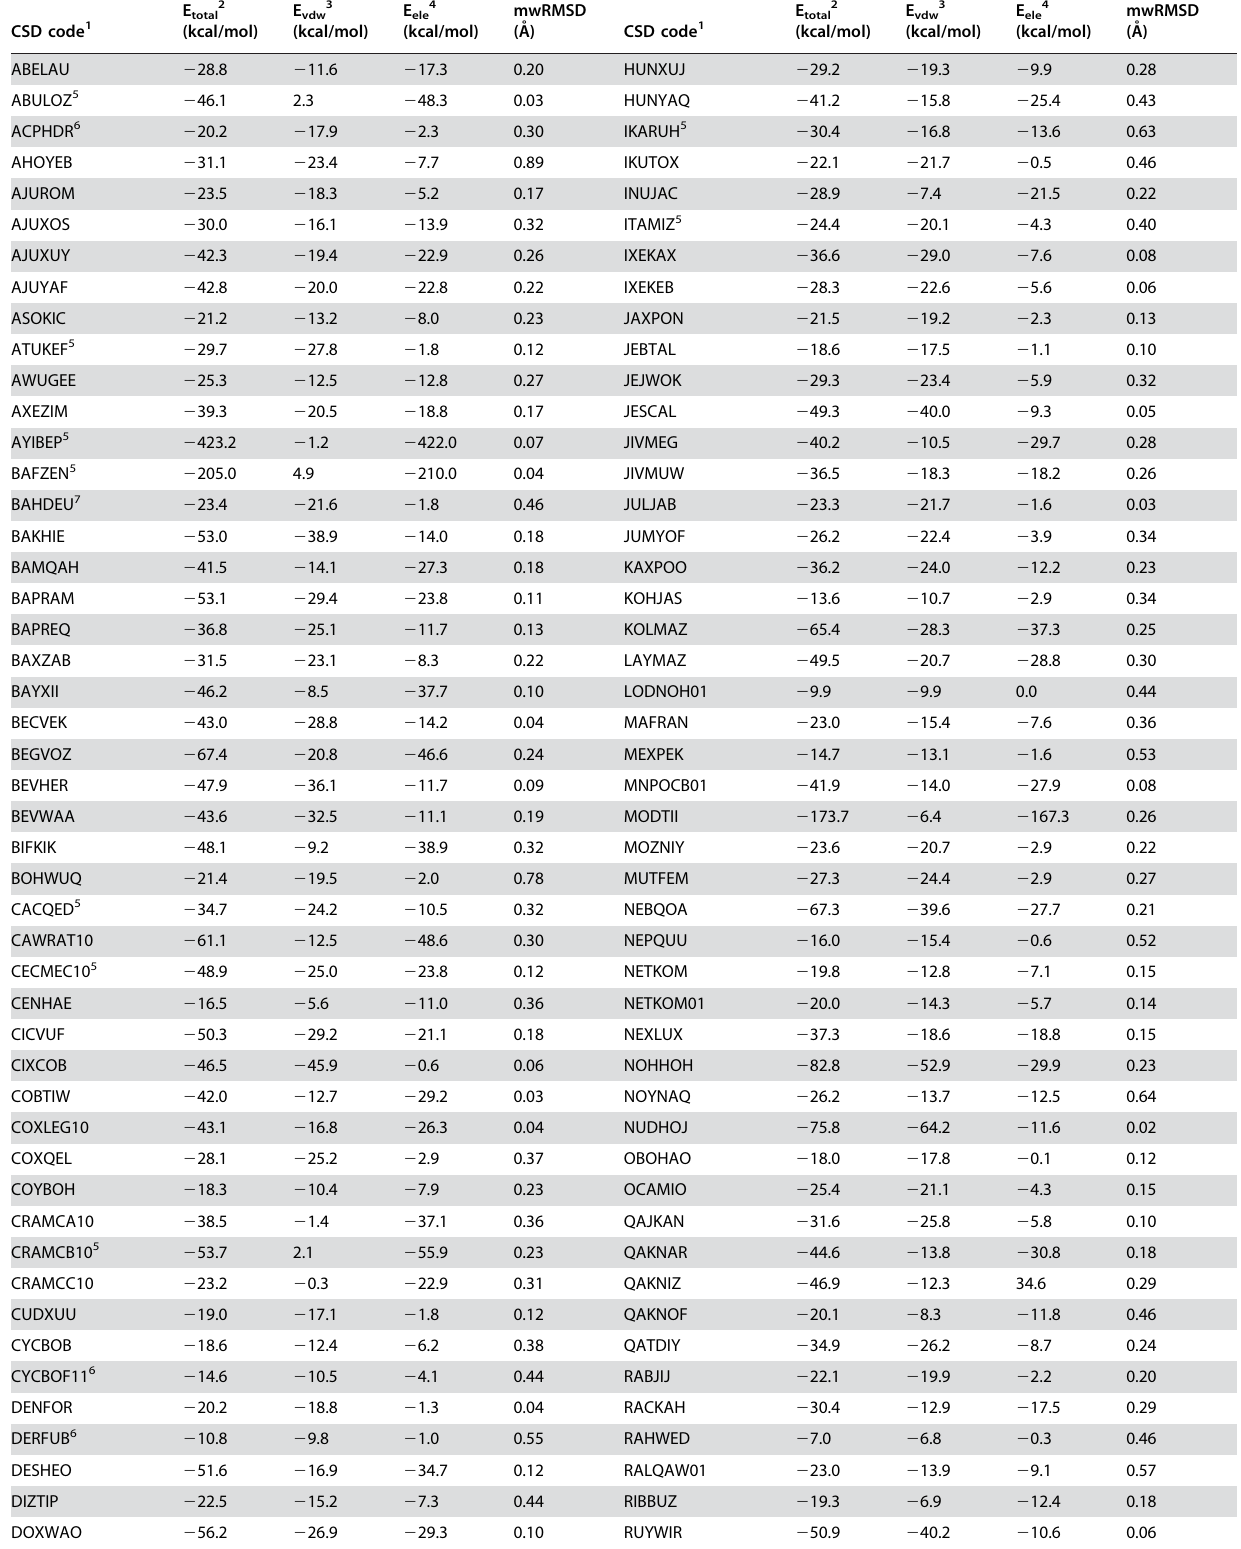
Table 4. The intermolecular interaction energies of the 161 small-molecule complexes generated by the EUDOC program and their mass-weighted root mean square deviations (mwRMSDs) relative to their corresponding crystal structures. .. ... .... ... ... .... ... ... .... ... ... .... ... ... .... ... ... .... ... ... .... ... ... .... ... ... .... ... ... .... ... ... .... ... ... .... ... ... .... ... ... .... ... ...